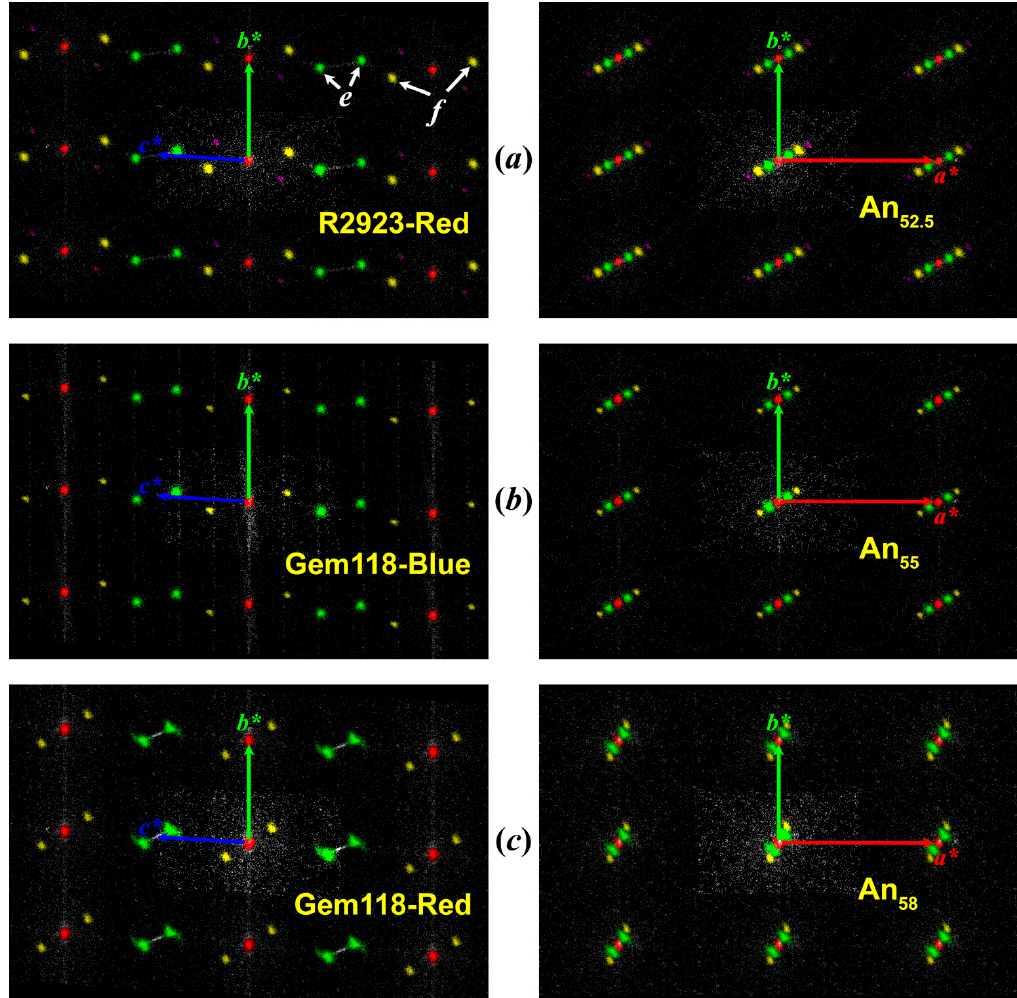
Figure 9. Comparison between the modulation vectors of the red-iridescent R2923 ( a ), the blue-iridescent Gem118 ( b ), and the red-iridescent Gem118 ( c ), by collapsing all the reflections in the diffraction data to the reciprocal lattice range. The blue-iridescent Gem118 shows a slightly tilted and shorter modulation vector compared to the red R2923, which agrees well with the ~2.5 mol% difference in their An#. The modulation vector of the red-iridescent Gem118, however, is much more tilted and shorter compared to the other sample, disproportionate to the composition difference. The e -reflections (green color) of the red-iridescent Gem118 also show two separate clusters of irregular shapes, corresponding to the two different modulation vectors, which can be observed in the precession image (Figure